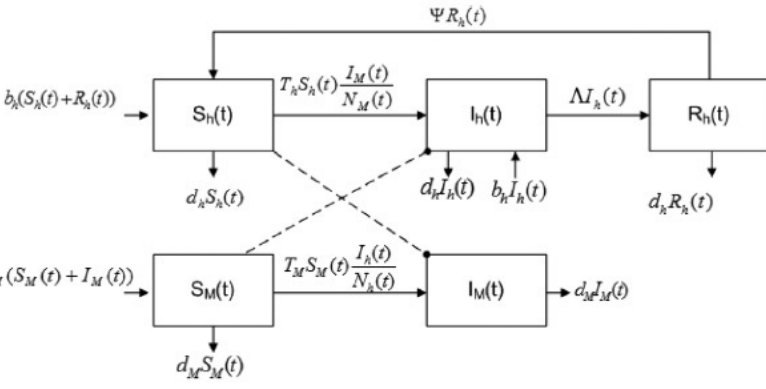
Fig. 2 Diagram for the mathematical model for the dynamics of the zika virus in human and mosquito